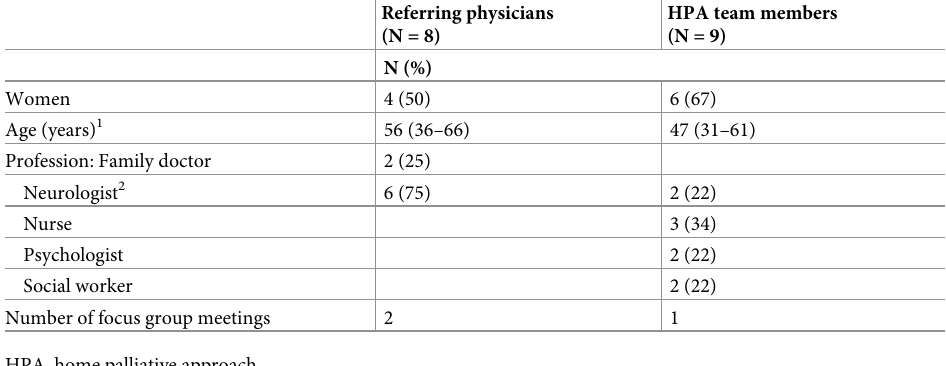
Table 2. Characteristics of focus group meeting